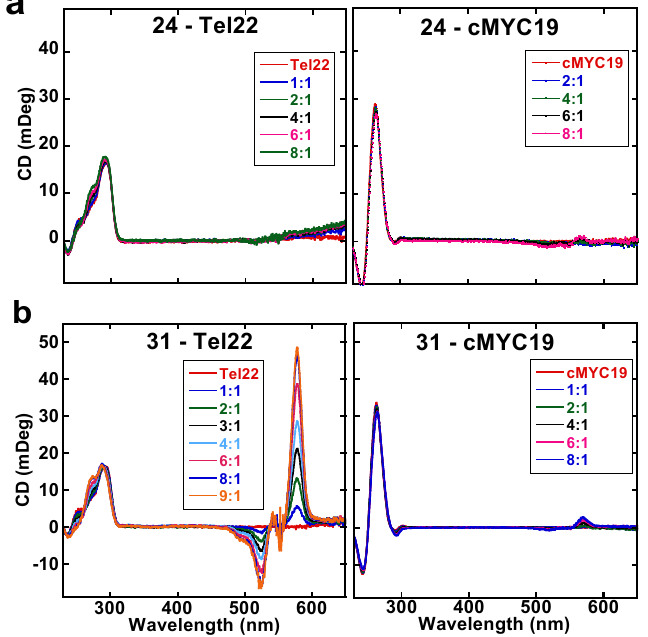
Figure 3. CD spectra of the parent cyanine ( 24 , panel a ) and the brominated analog ( 31 , panel b ) with Tel22 and cMYC19 quadruplex sequences. The ligands were titrated into the quadruplex solutions (5 µM) until no further change in ICD signals were obtained. The insets show the mole ratio of drug:DNA.